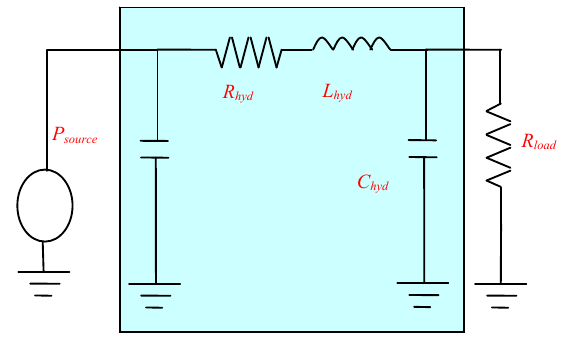
Figure 3. Electric analogy of the flow